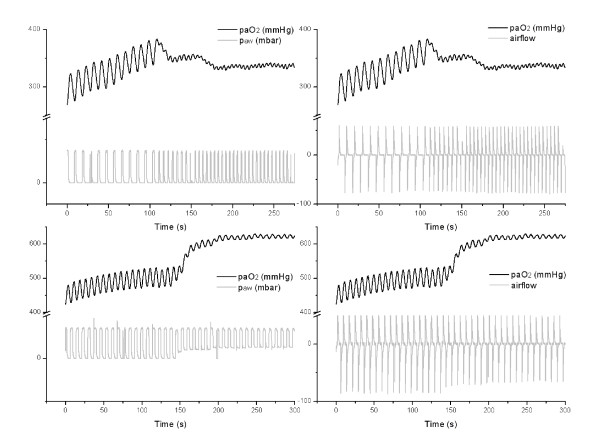
Real-time recording of paO2 oscillations before and after intervention. Exemplary real-time data (time resolution: 10 Hz) of RRind (upper graphs) and PEEP (lower graphs) intervention following amplitude-stable paO2 oscillations representing cyclic R/D. A steady-state between recruitment and derecruitment is hardly achieved before the interventions. Correlation to airway pressure (paw) and airflow demonstrates the respiratory-dependent character of Δ paO2.